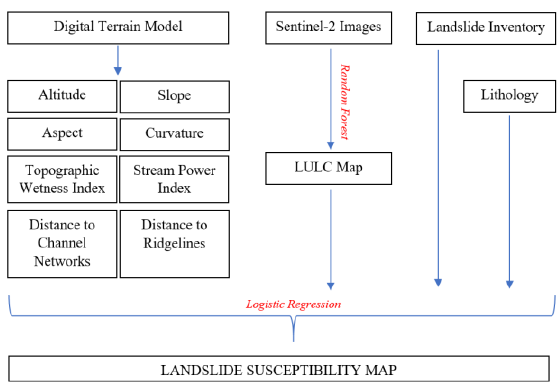
Figure 2. Overall workflow of the